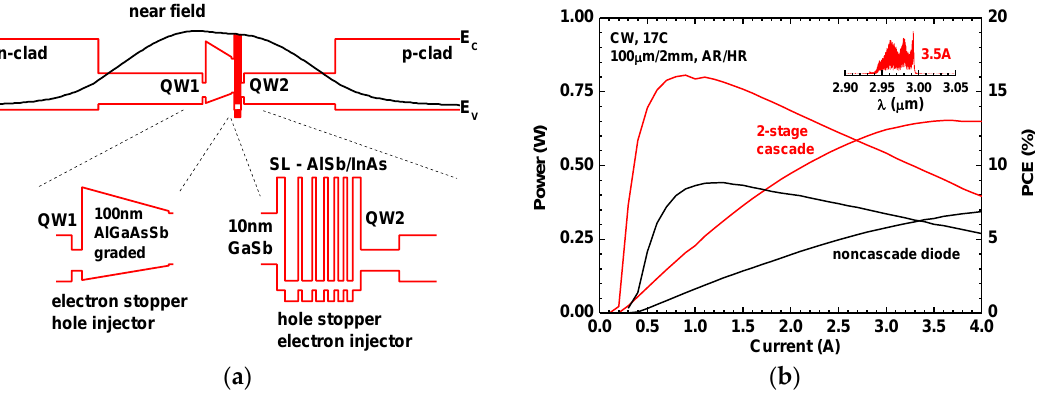
Figure 1. ( a ) Schematic band diagram of the two-stage GaSb-based type-I quantum well (QW) cascade diode lasers. Insert magnifies the parts of laser heterostructure responsible for electron transfer from valence band of QW1 to the conduction band of QW2. ( b ) CW light-current and power conversion characteristics measured at 17 °C for 100-μm-wide, 2-mm-long, anti-/high-reflection coated two-stage cascade and reference diode lasers [9]. Insert shows the cascade device emission spectra corresponding to the maximum power level.